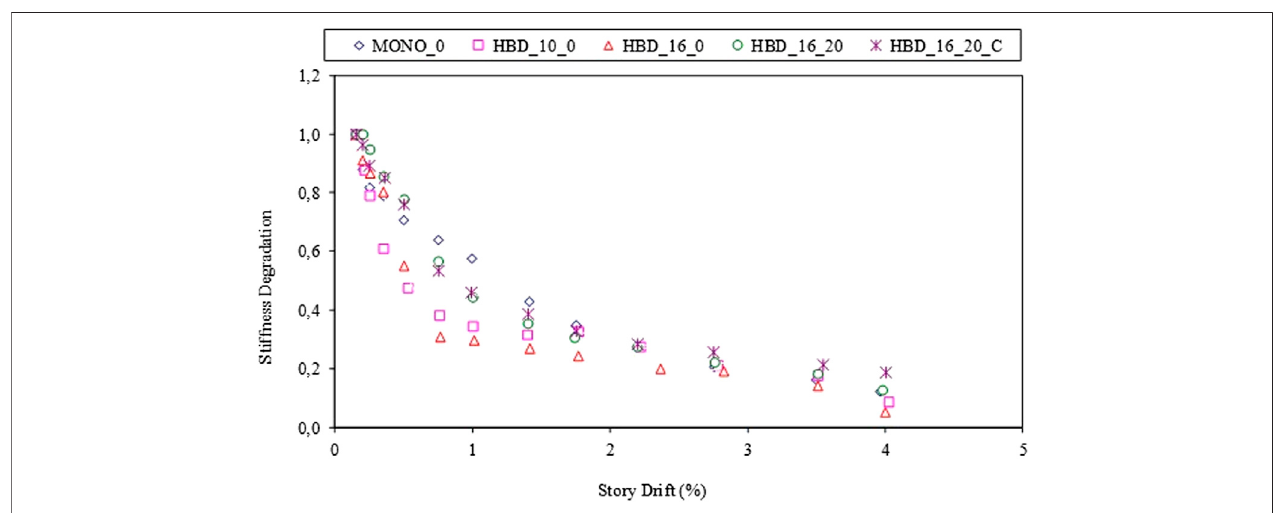
FIGURE 12 | Stiffness degradation of